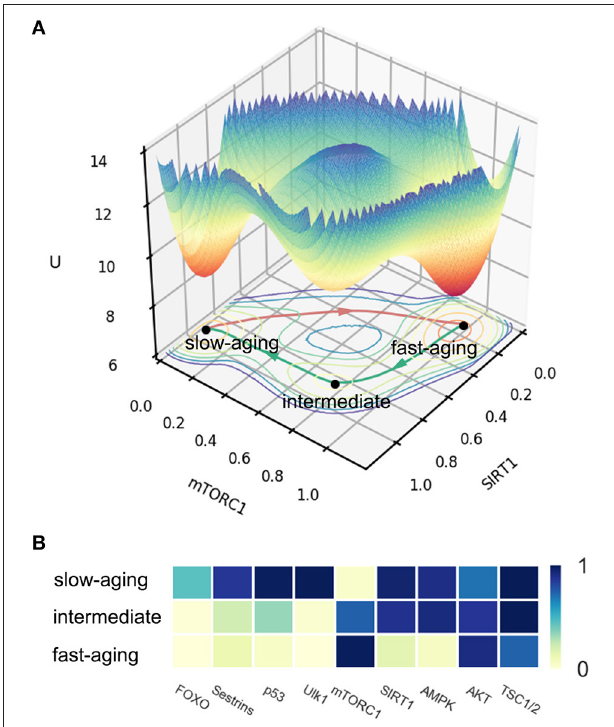
FIGURE 2 | The potential landscape and gene expression levels of fast-aging and slow-aging. Red arrows represent the dominant path from slow-aging to fast-aging. Green arrows represent the dominant paths from fast-aging to slow-aging. (A) The potential landscape of fast-aging and slow-aging. (B) Gene expression levels of fast-aging and